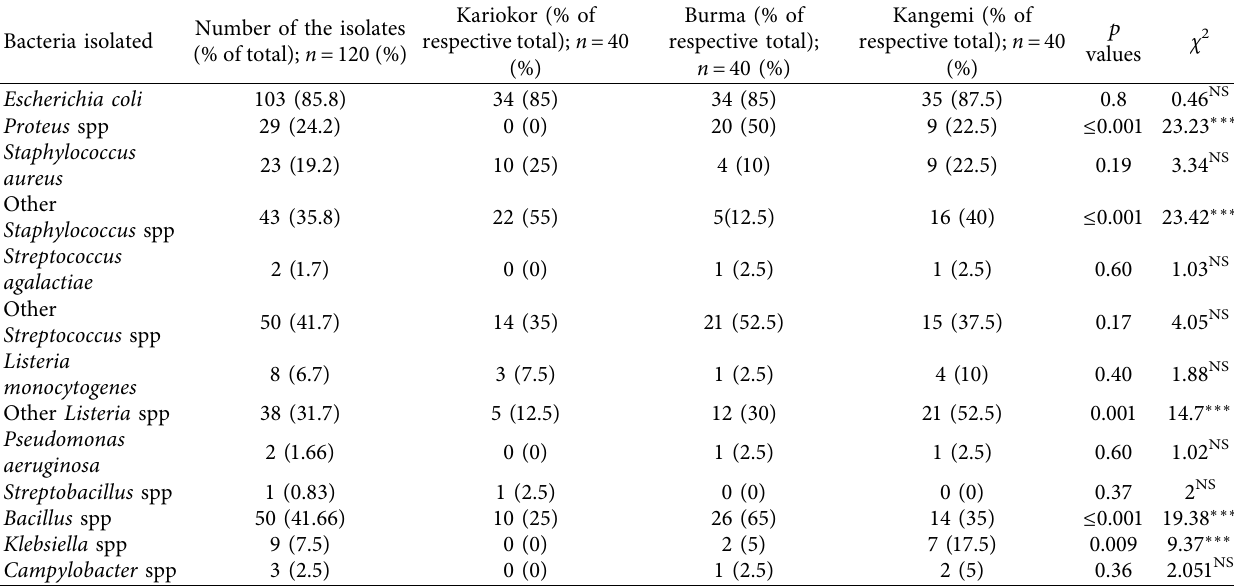
Table 2: Prevalence of bacteria isolated from Kariokor, Burma, and Kangemi slaughterhouses and their chi square values. Kariokor (% of Burma (% Number of the isolates Bacteria isolated (% of total); n � 120 (%)